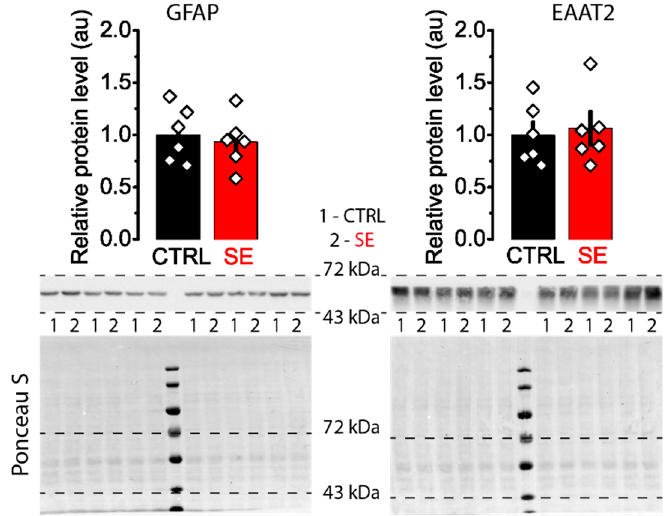
Figure 7. Representative western blots of GFAP and EAAT2 from the dorsal hippocampus of control (CTRL) and experimental (SE) groups. Bar graphs (means ± SEM) illustrate the expression levels of GFAP and EAAT2, which were normalized to total protein. Each rhombus represents a value obtained in individual animals. Images: the upper part shows the chemiluminescent signal, and the lower part shows the Ponceau S.